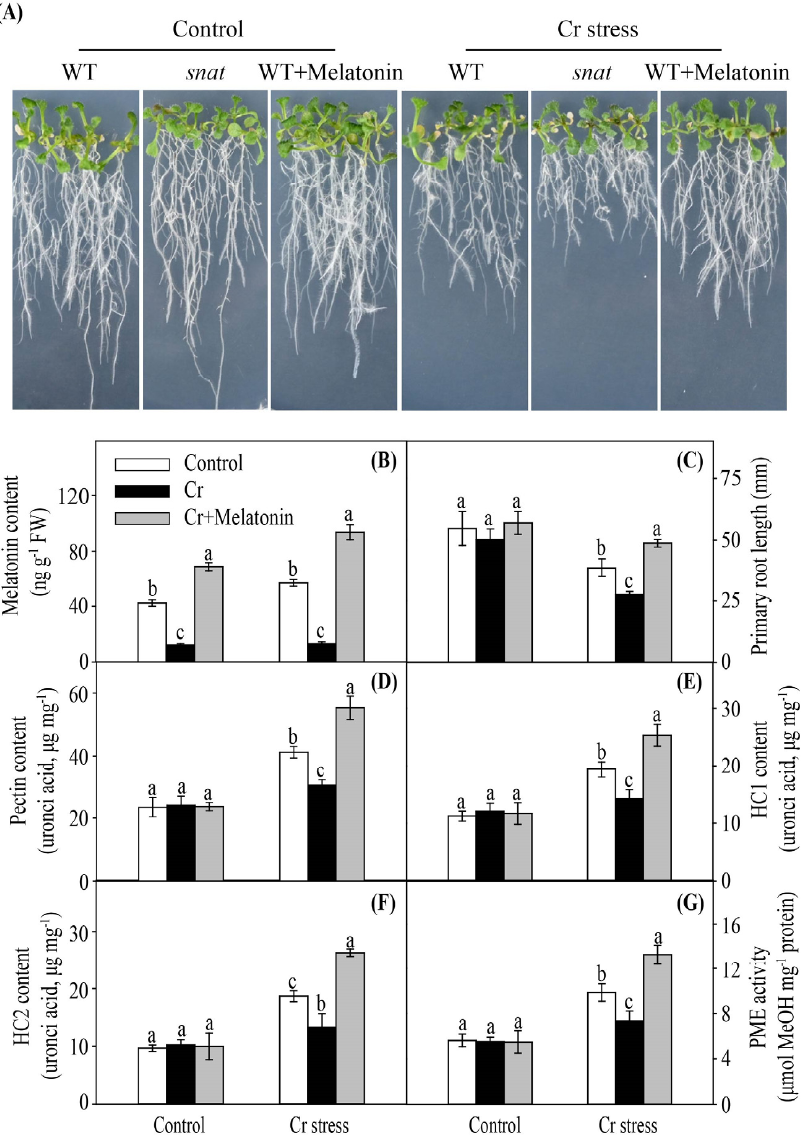
Figure 9. Phenotypes of Arabidopsis after Cr stress treatment ( A ). The modulation of melatonin affects endogenous melatonin content ( B ), root growth ( C ), uronic acid contents of cell wall polysaccharides (( D ), Pectin; ( E ), hemicellulose 1; ( F ), hemicellulose 2), and pectin methylesterase (PME) activity ( G ) in Arabidopsis roots under Cr stress. Different letters in one measure (control or Cr stress) denote significant differences at p < 0.05. Data are shown as mean ± SE ( n =